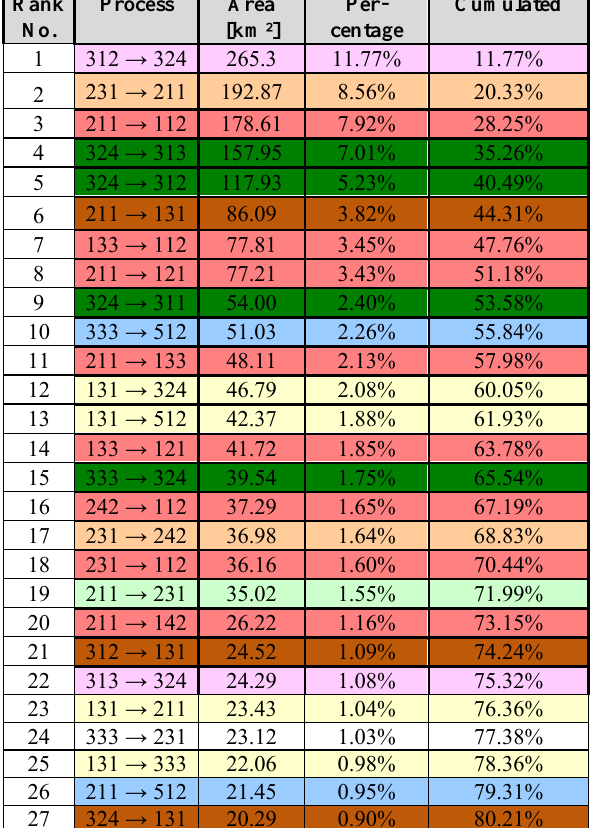
Table 3: The dominating 27 change classes due to CLC